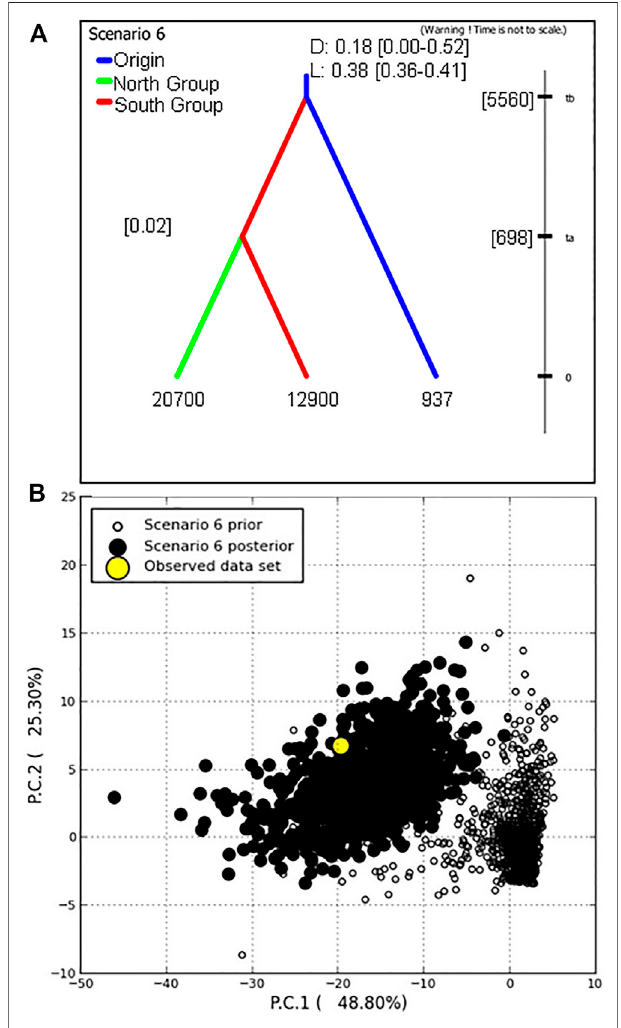
FIGURE5| Thebest-supportedscenariobyDIYABC(Scenario6)forthe genotyped Pyrus calleryana dataset. (A) Scenario 6 had the highest support; here the Origin Group (relative effective population size of about 937 individuals) diverged the South Group (effective population size of about 12900 individuals) at about 5560 generations into the coalescent, from which the North Group diverged at about 698 generations into the coalescent (effective population size of about 20700 individuals). D and L indicate the relativesupportvaluesderivedfromdirectandlogisticregressionapproaches, respectively, with their probability values of 95% con fi dence intervals given in squarebrackets([]). “ t ” representsthetimeofoccurrenceofeventsexpressed in generations. (B) Model-checking of the closest 1% simulated prior and posterior datasets was performed using two PCAs explaining the most variance in the summary